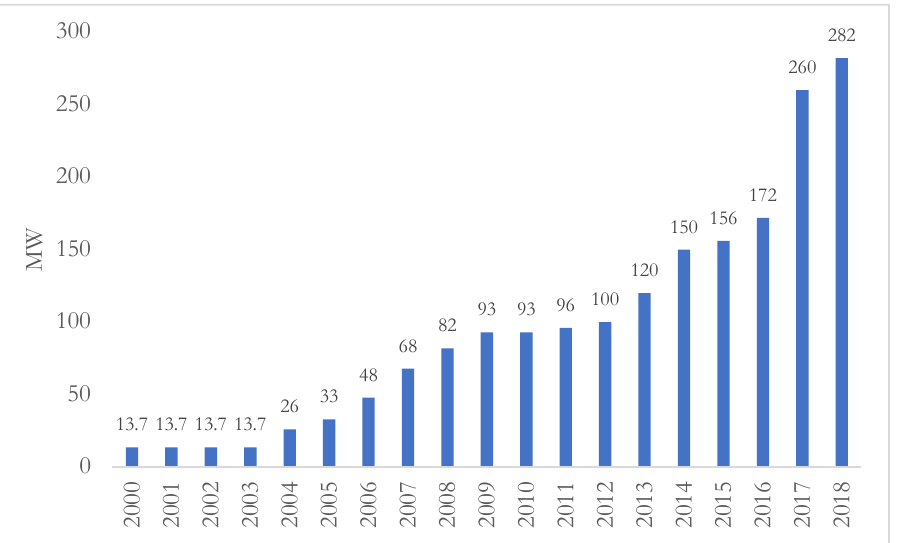
Figure 9. Development of wind capacity in Iran, 2000–2018. Source: Tavanir, detailed statistics of Iran electric power generation, 2018.